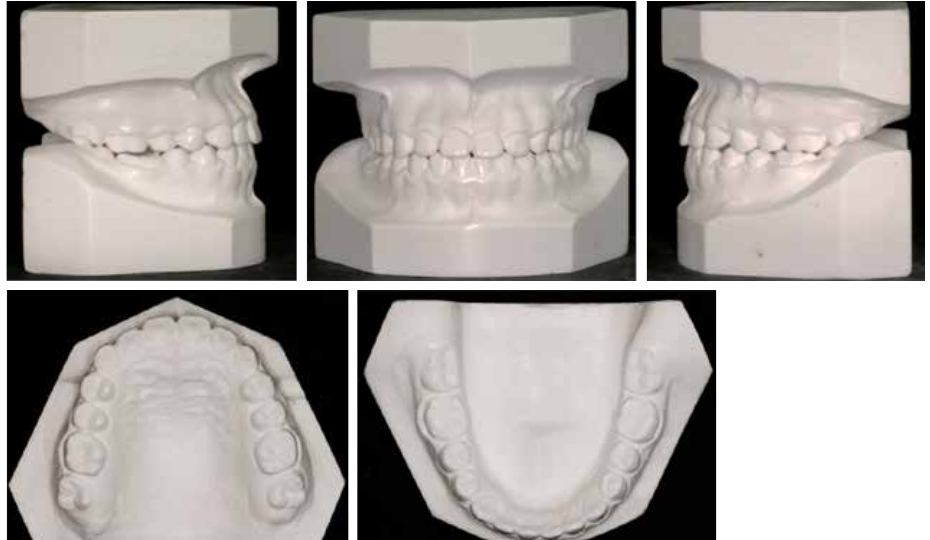
Figure 10. Post-treatment dental casts.